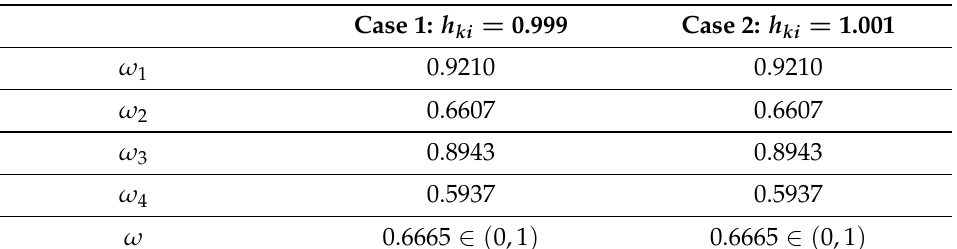
Table 1. Comparisons the influences between big impulse and small impulse when other data are unchanged.